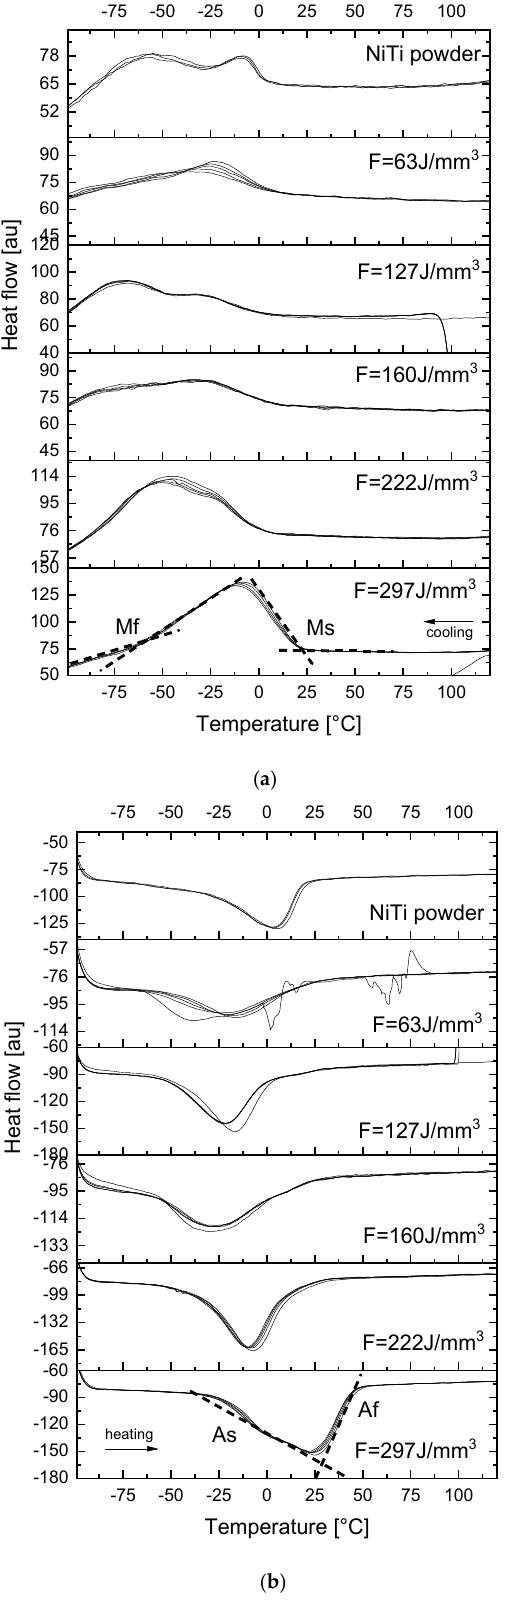
Figure 2. DSC measures of the initial NiTi powder and the NiTi samples, produced at varying the laser fluence. The DSC scans were splitted in cooling ( a ) and heating ( b ), respectively; tangent lines to the DSC profiles for detecting the transformation temperatures are depicted.